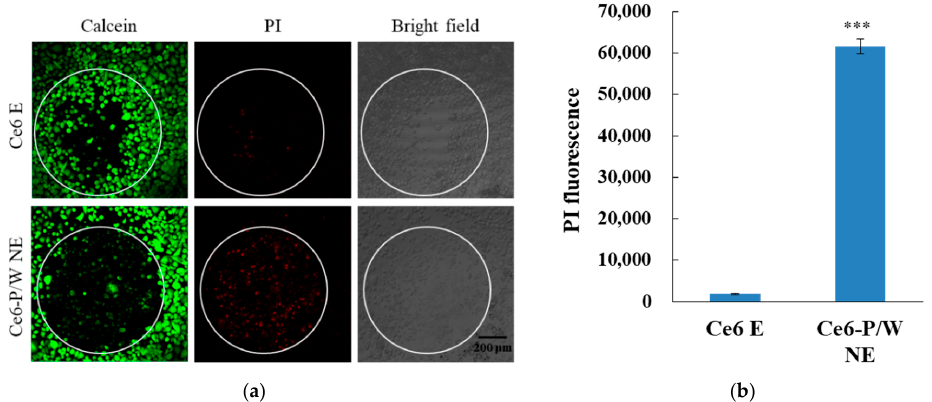
Figure 4. ( a ) Calcein/PI staining and corresponding bright-field images and ( b ) necrosis indicated by PI fluorescence signals of cells treated with Ce6 E or Ce6-P/W NE upon light irradiation (633 nm, 50 mW/cm 2 ) in a normoxic condition for 45 s. Ce6-P/W NE concentration, 400 μ g/mL. Ce6 concentration, 8 μ g/mL. Green color shows living cells, and red color shows dead cells. The white circle indicates the irradiation area. Data were presented as mean value ± standard deviation. After Levene’s test for equality of variances, Student’s t test was employed for the comparison of mean values. n = 3. ***, p < 0.001. PI, propidium iodide. Ce6 E, chlorin e6 emulsion. Ce6-P/W NE, chlorin e6-perfluoropolyether (PFPE)/water nanoemulsion.